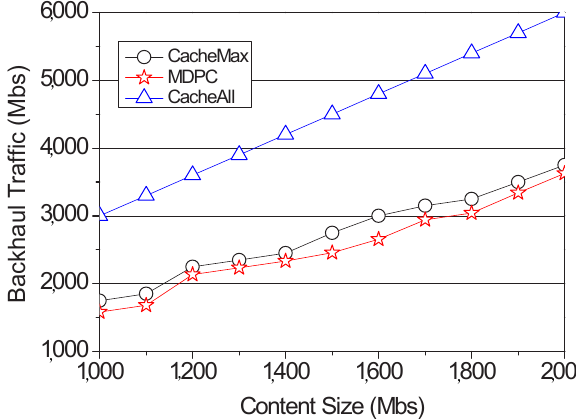
Figure 6. Backhaul traffic of according to the content size.